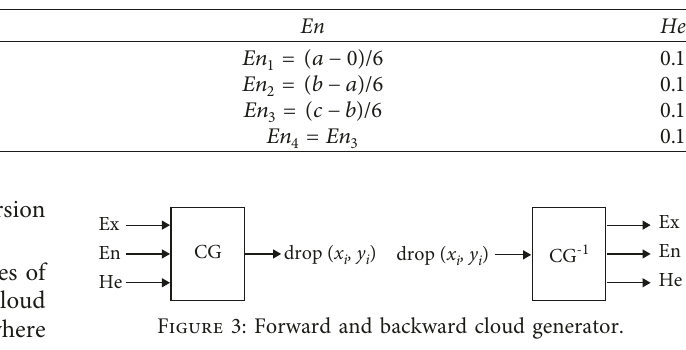
Table 2: Rules for calculating numerical features of cloud models.